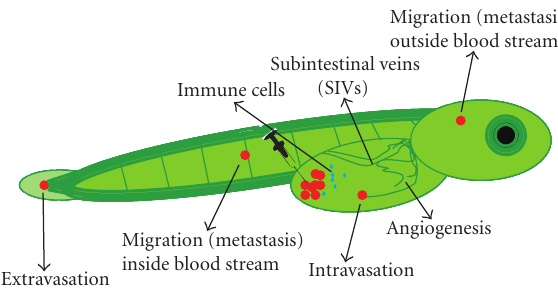
Figure 6: Cell migration, angiogenesis, and host response. Schematic representation of a transgenic zebrafish embryo in which all blood vessels are labeled in green. After injection of cells labeled in red, the transparent embryos are screened daily to investigate processes like intra/extravasation, migration (metastasis), and signs of angiogenesis. In addition, by labeling immune cells with another color (blue in this figure) or by examining the zebrafish gene expression profiles, the host response to the injected cells can be